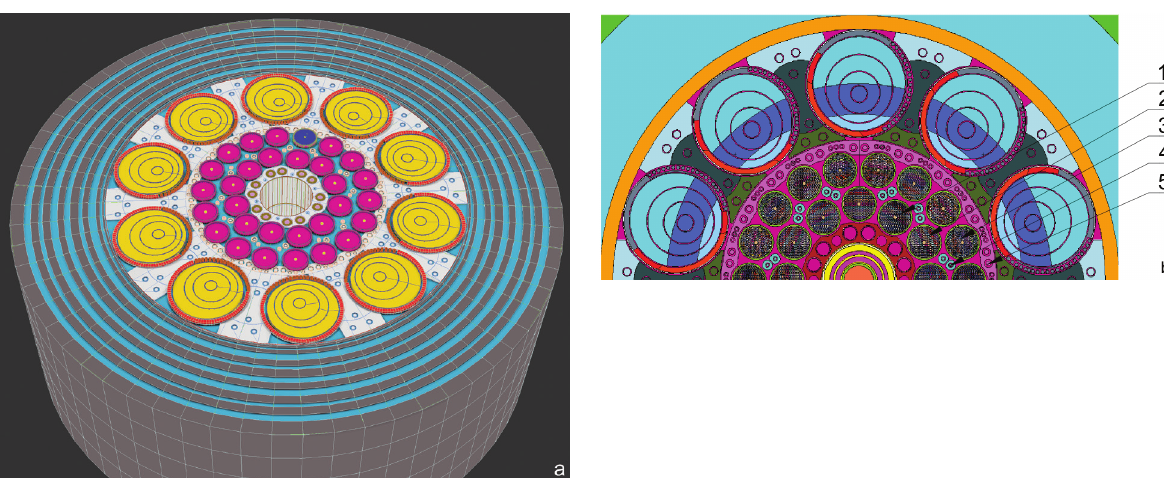
Figure 2. Computational model of the reactor core for the MCNP5 code (Irkimbekov et al. 2019): a. 3D model of the IVG.1M reactor core; b. Cross section of the 3D model (1, 2, 3 – water-cooled technological channel of the first, second and third row; 4 – interchannel beryllium displacers; 5 – side beryllium displacer)